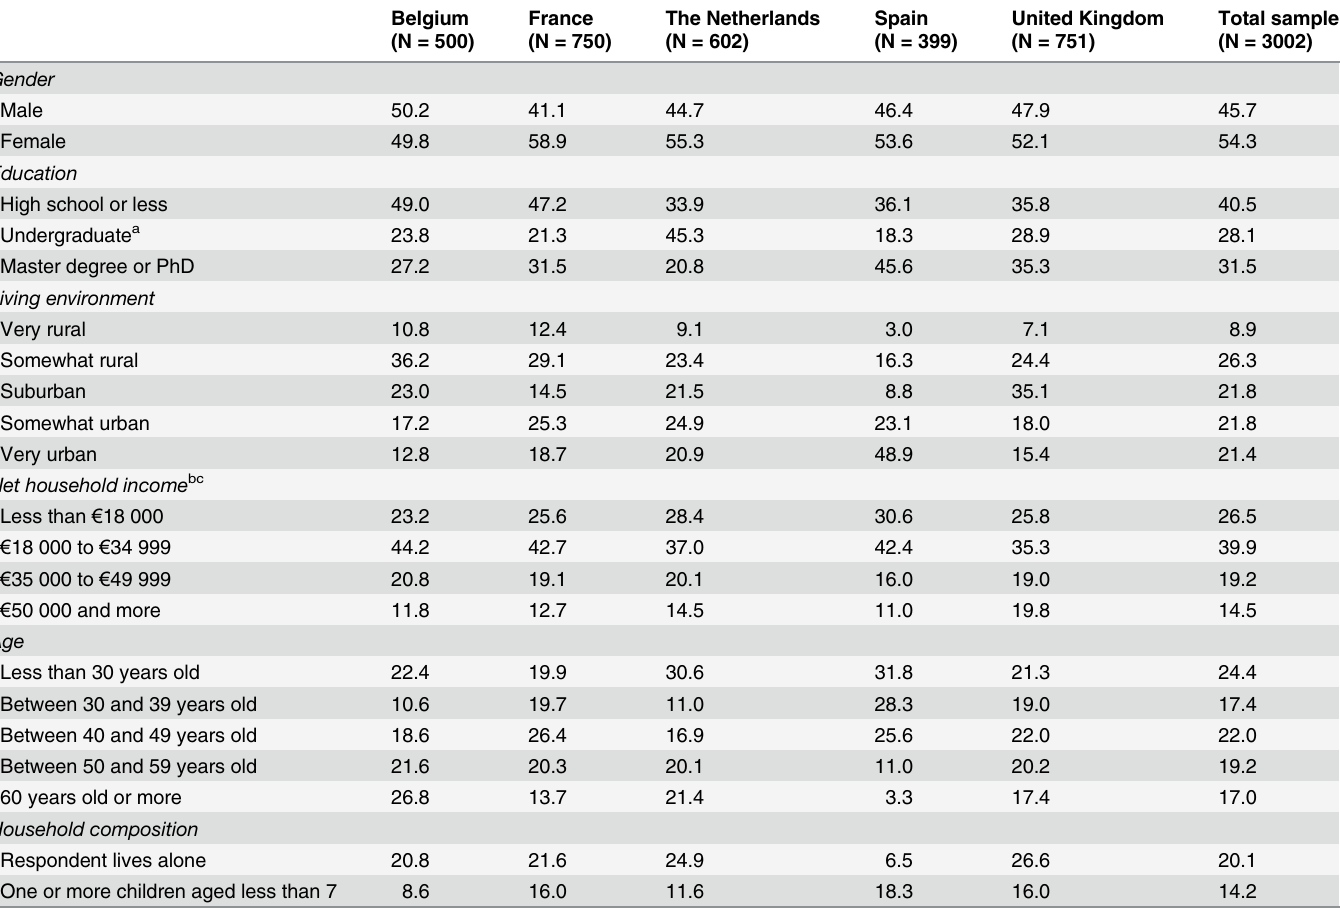
Table 1. Socioeconomic characteristics by country and for the total sample